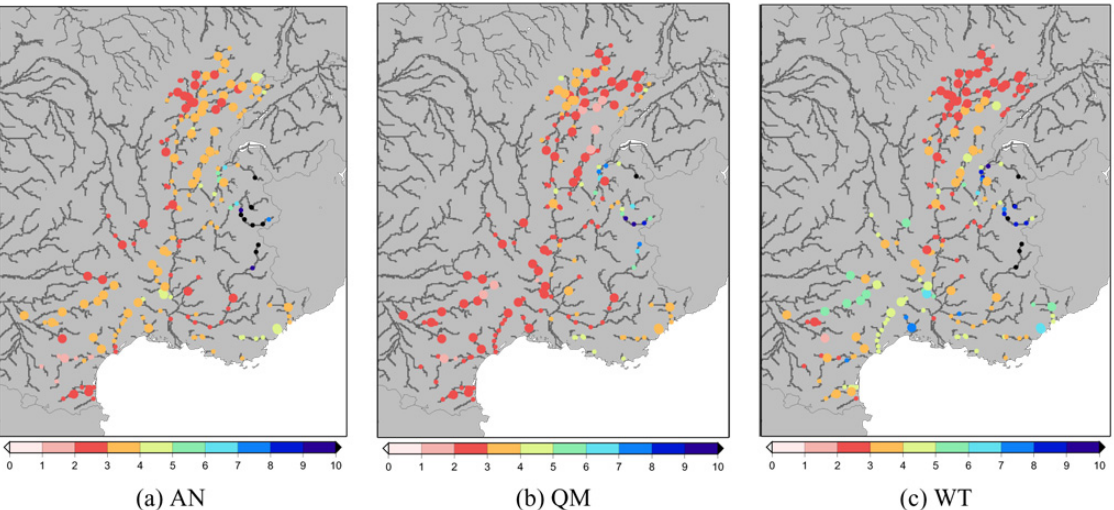
Fig. 14. Return period in years calculated for 2035–2064 of the discharge corresponding to the QMNA5 of 1970–1999. Values smaller than 5 indicate a decrease of the return